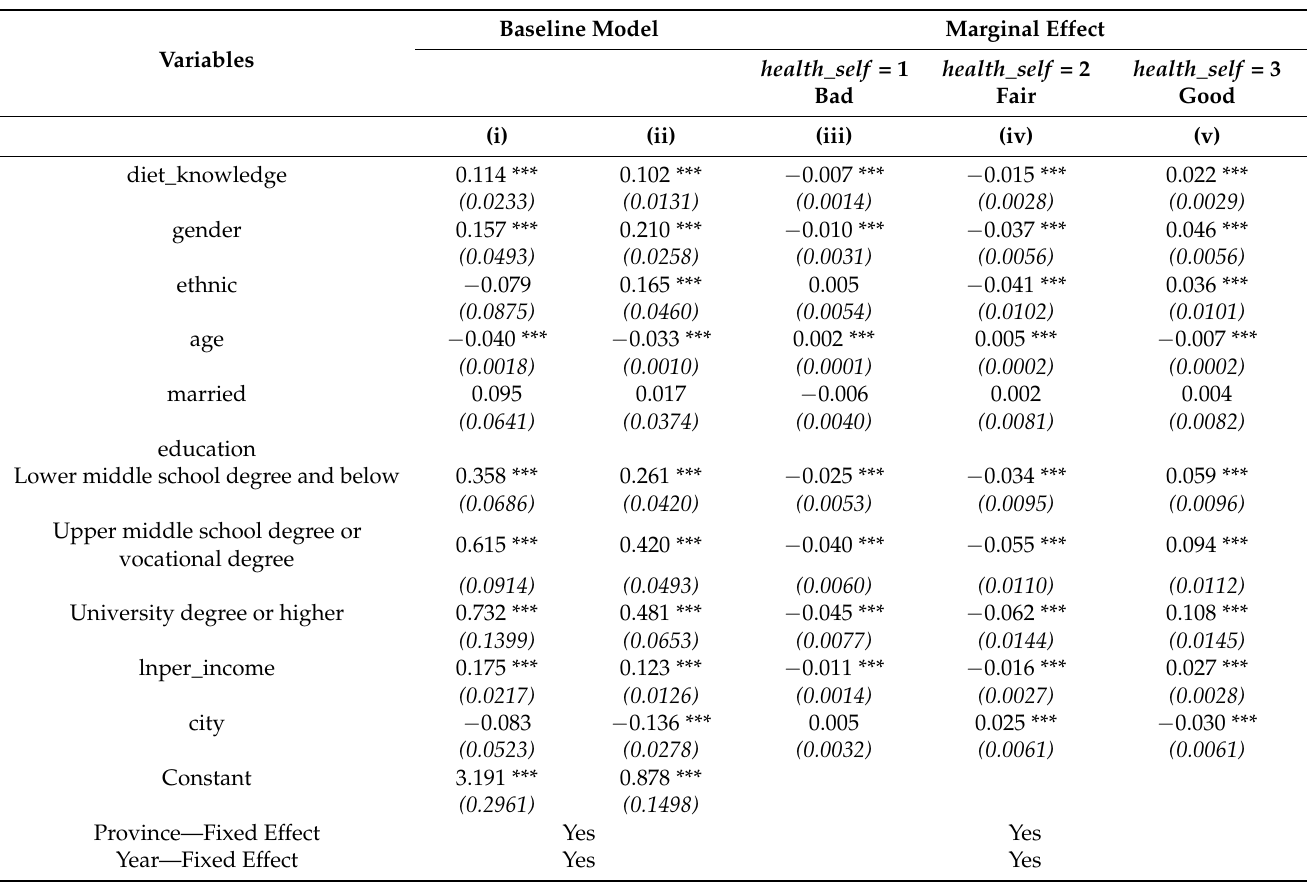
Table A4. Robustness check of the effect of dietary knowledge on health III (estimating with the reduced model without covariates smoking and alcohol